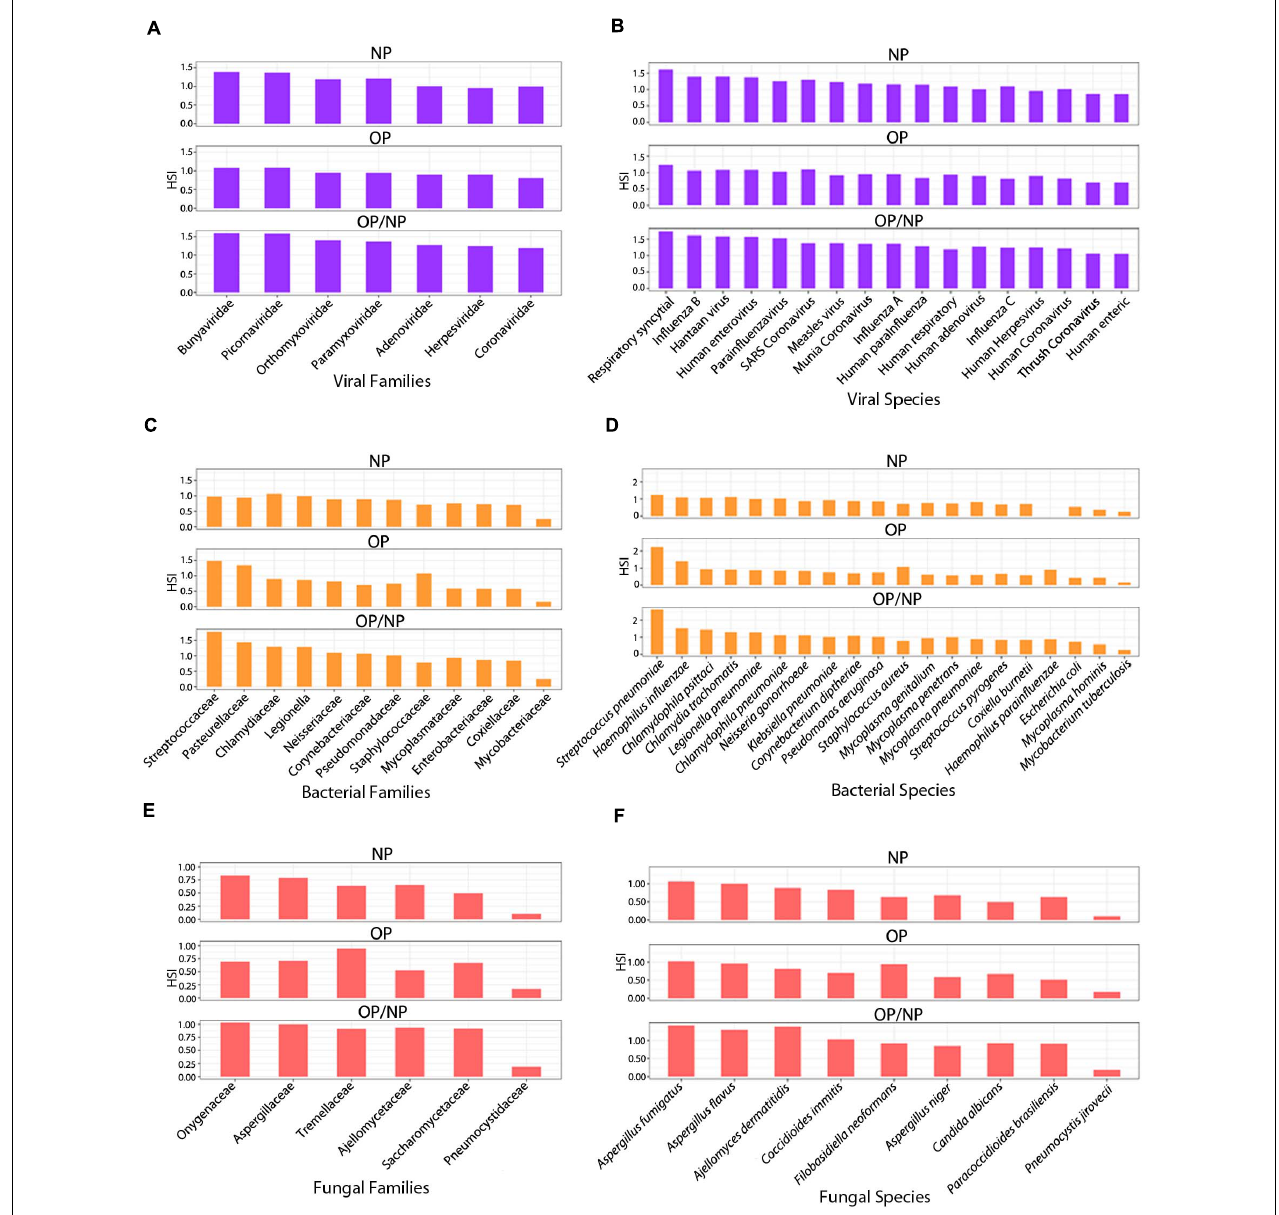
FIGURE 4 | Respiratory agent signature families identified in patient swab samples. Series of bar plots representing average HSI of signature (A) viral, (C) bacterial and (E) fungal families and (B) viral, (D) bacterial and (F) fungal species identified in Oropharyngeal (OP), Nasopharyngeal (NP), and Oropharyngeal/ Nasopharyngeal (OP/NP) patient swab